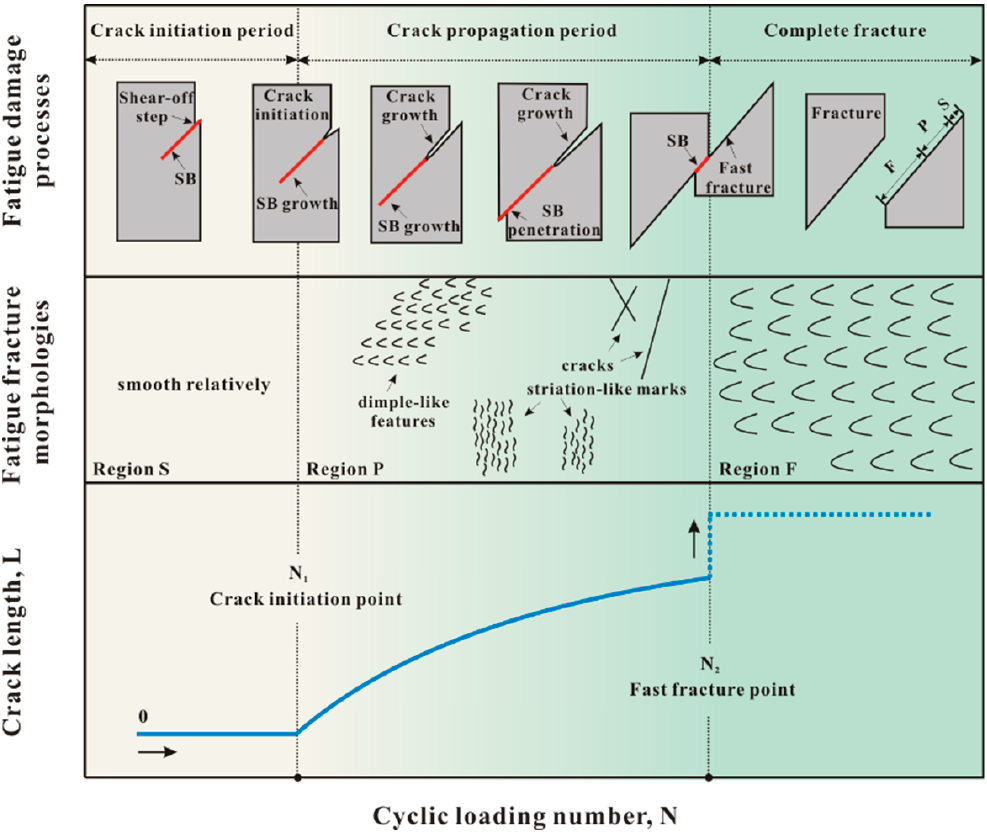
Figure 2. Fatigue damage morphologies under different cycles [42]: ( a , b ) N = 5000 cycles; ( c , d ) N = 8000 cycles; ( e , f ) N = 12,000 cycles; ( g , h ) N = 18,000 cycles; ( i ) N = 20,000 cycles.